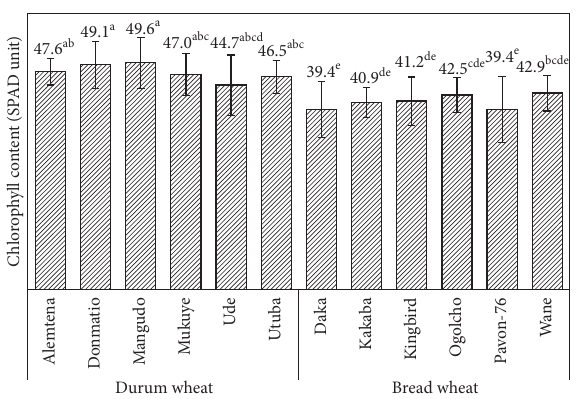
Figure 4: Means for the main effects of variety and water stress on the relative chlorophyll content of durum and bread wheat in